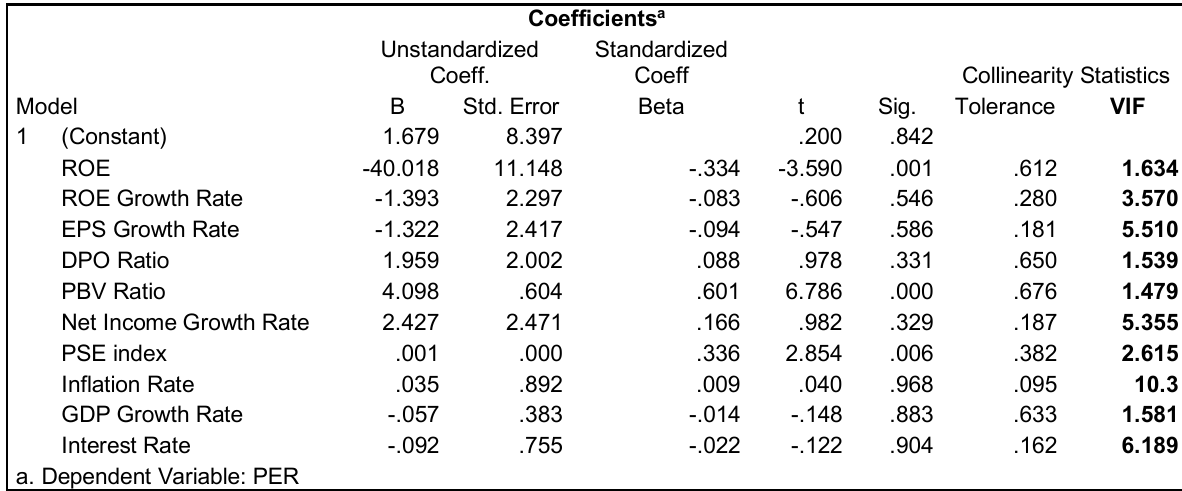
Table 4: Variance Inflation Factor (VIF)